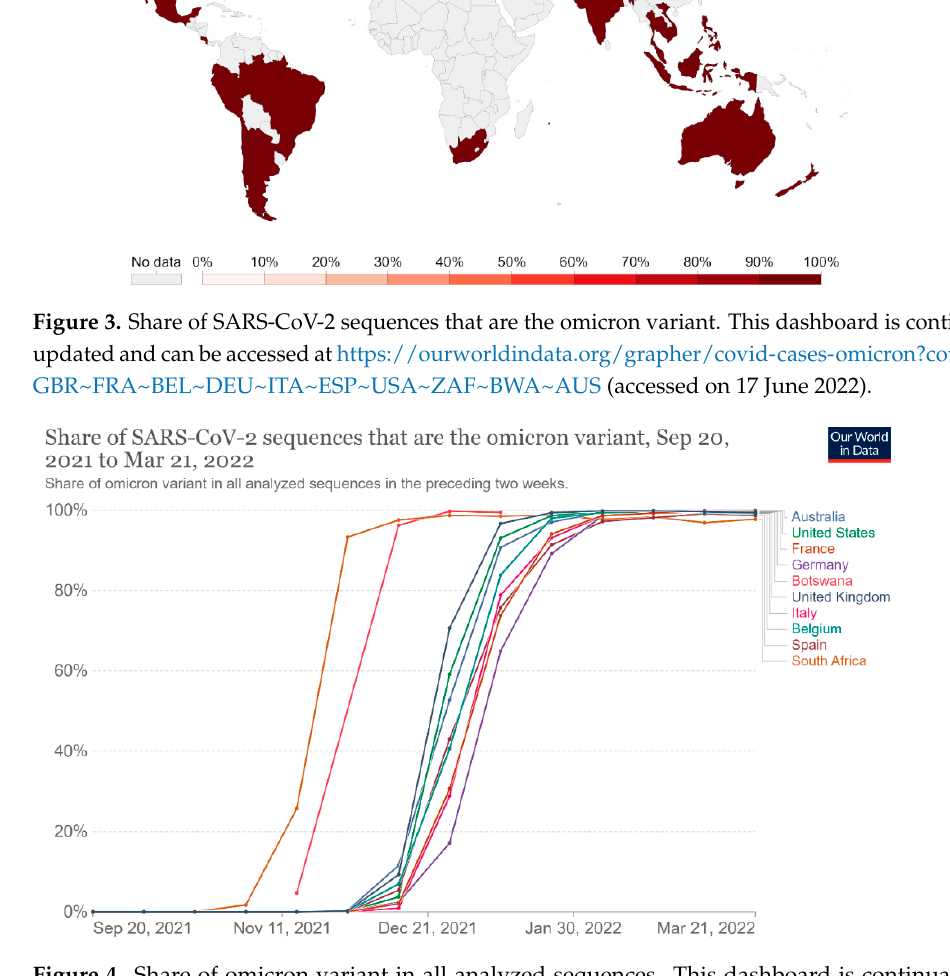
Figure 4. Share of omicron variant in all analyzed sequences. This dashboard is continually updated and can be accessed at https://ourworldindata.org/grapher/covid-cases-omicron?tab=chart&coun-